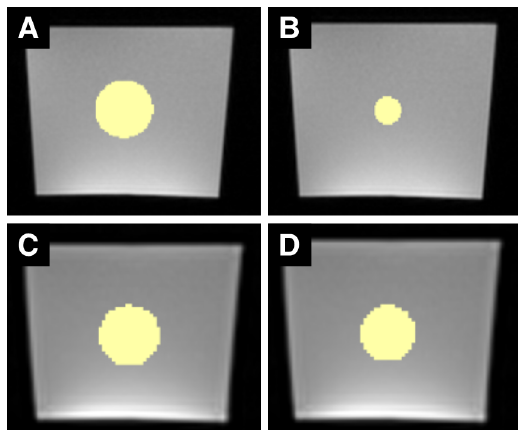
Figure 1. Sample set of MRI ROIs. ( A – D ) are examples of MR images of the phantom with differently sized ROIs (in yellow). ( A , B ) are images acquired with the T1w sequence, ( C , D ) are images acquired with the T2w TIRM sequence. The left column shows ROIs with a 16 mm diameter, the right column ROIs with a 16-pixel diameter. Due to the different spatial resolutions, the 16-pixel ROI in the T2w TIRM image has a greater diameter than the 16-pixel ROI in the T1w image. Both T1w and T2w TIRM-weighted images show typical, gradient-like inhomogeneities within the phantom (brighter at the bottom, darker at the top).